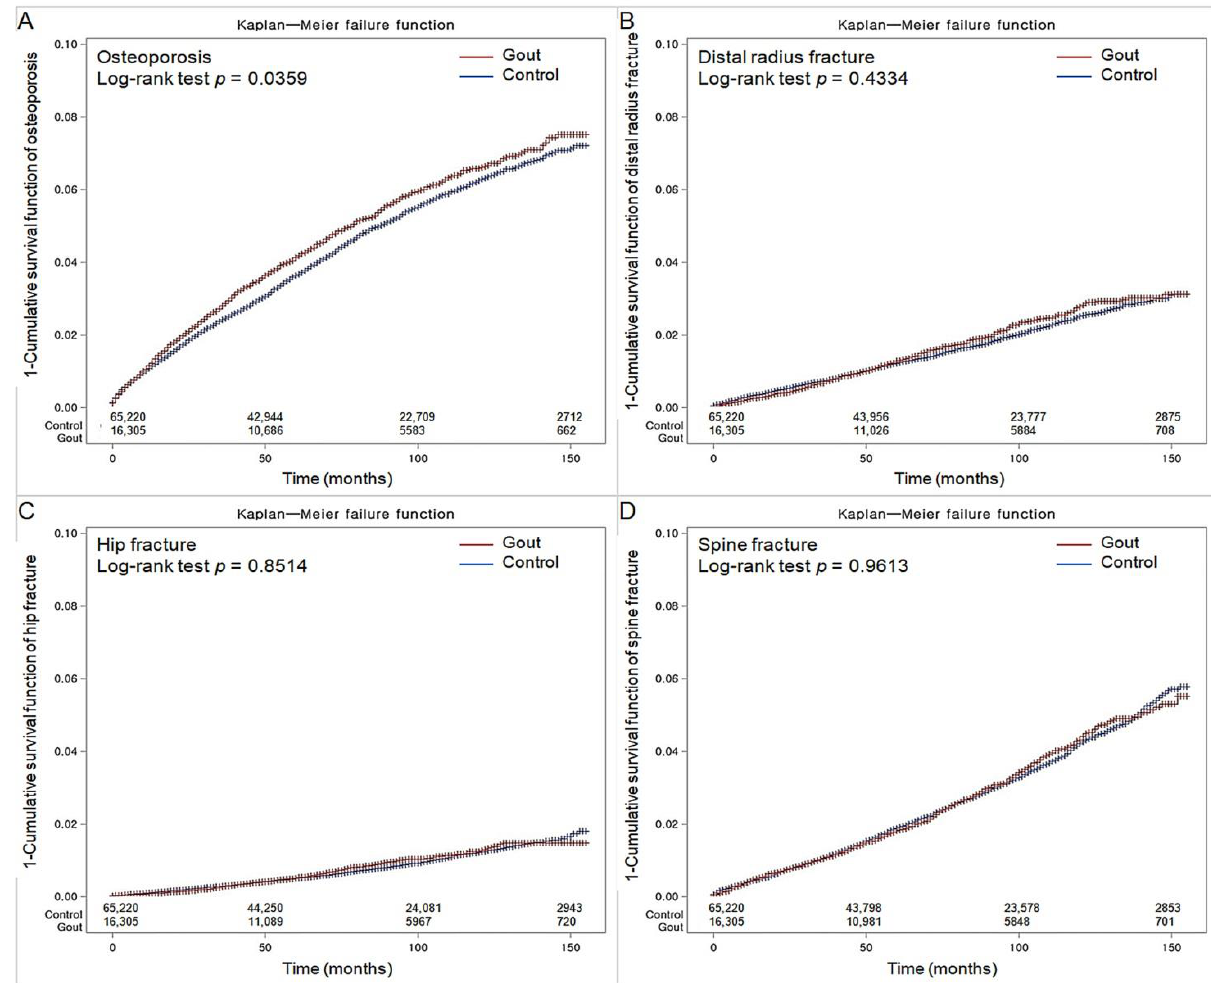
Figure 2. Kaplan-Meyer incidence probability of osteoporosis ( A ), distal radius fracture ( B ), hip fracture ( C ), and spine fracture ( D ) in patients with gout and control populations within 13 years of the index date.